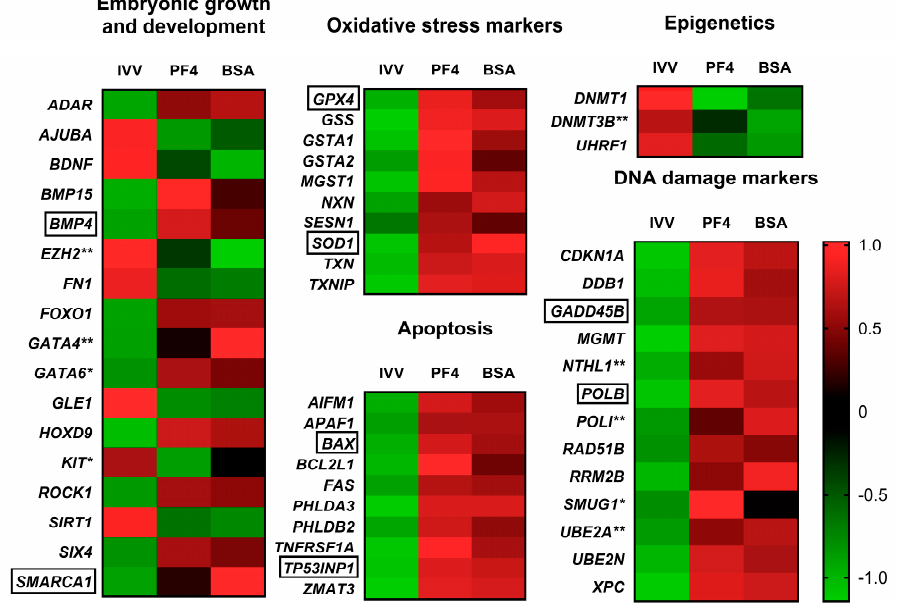
Figure 7. Heat maps grouping differentially expressed genes by specific functions at the embryonic level or as markers of damage for the three experimental groups: in vivo-derived embryos (IVV), in vitro embryos cultured in defined medium (PF4) and in vitro embryos cultured in undefined medium (BSA). * Indicates a gene considered differentially expressed in the case of the PF4 (PF4: platelet factor 4) versus IVV comparison but not in the BSA (BSA: bovine serum albumin). versus IVV comparison. ** Indicates a gene considered as differentially expressed in the BSA versus IVV comparison but not in the PF4 versus IVV comparison. Genes without any symbol indicate that they were considered differentially expressed in both comparisons. Genes surrounded by a box were selected for validation by q-PCR.